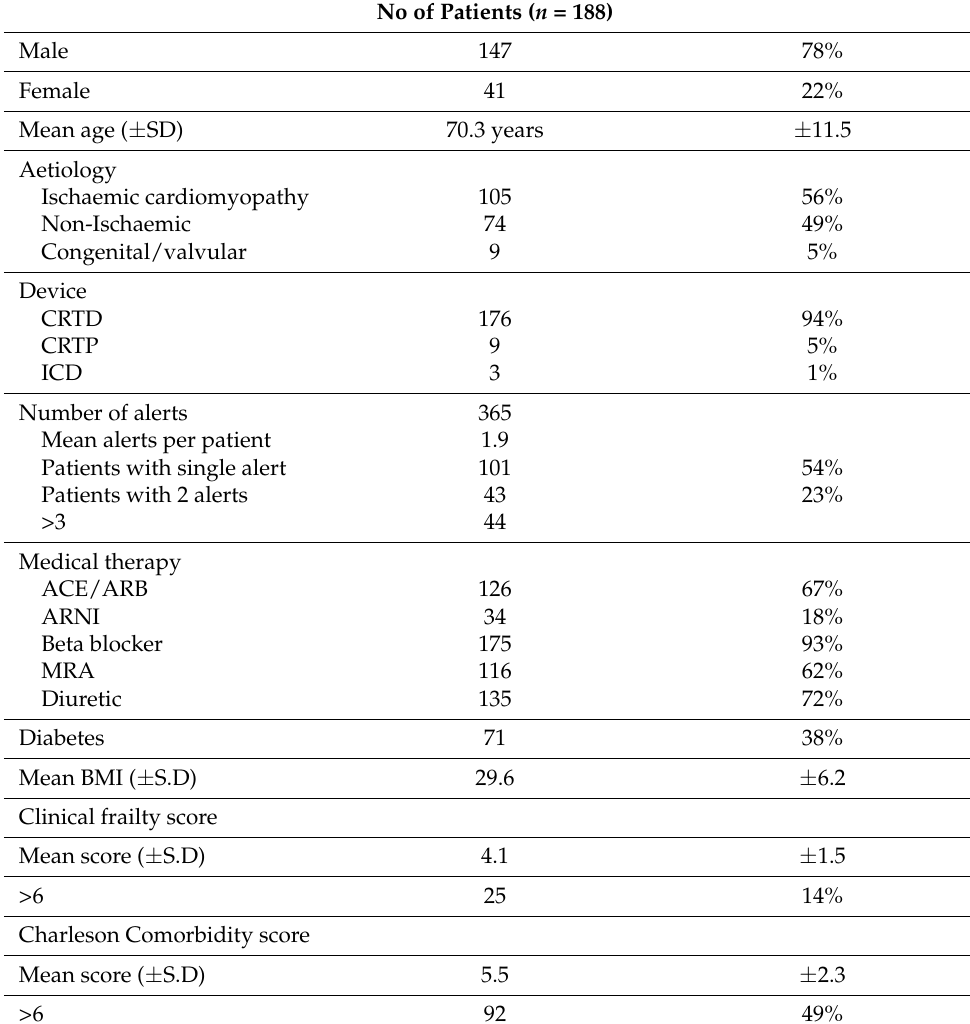
Table 1. Demographics of the study